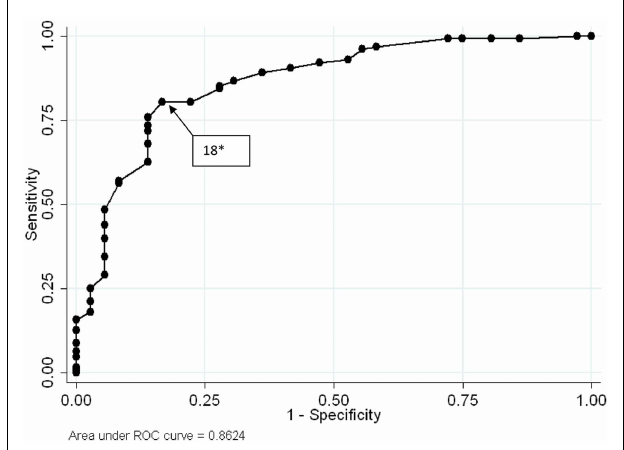
FIGURE 1 | Receiver operating characteristic curvesAUDIT for patients admitted for drunkenness . *Optimal threshold scores {by calculating the indices of quality [number total of subjects × k (1,0) × k (0,0) (42)]} for detecting alcohol dependence. According to the MINI (41), alcohol dependence was established from a positive response in three or more of the seven domains on DSM-IV diagnostic criteria of